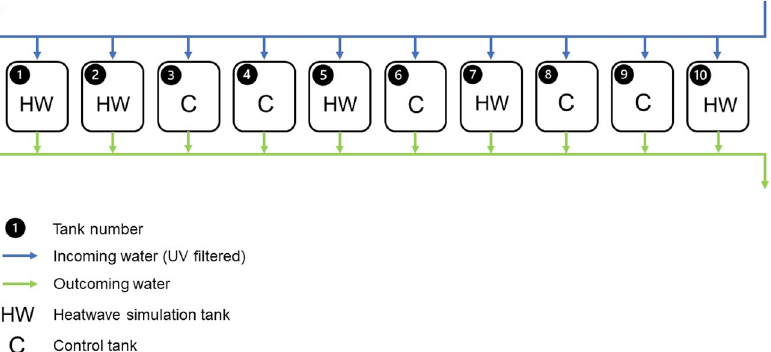
Figure 5. Schematic representation of the experimental setup. Tank number, random treatment assignation (Control, C and Heatwave, HW) and water flow direction (open